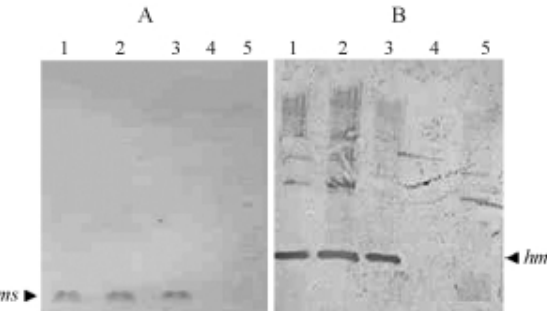
Figure 3 - Hybridization with the HmsH probe and DNA from strain P. CE 882R as positive control (lines 1); P. Exu 340/RWB (line 2); YP 375/4RWB (line 3); YP 375/16WRP (line 4); and YP 375/22W (line 5), digested with Dra I (A) and Ava I (B).